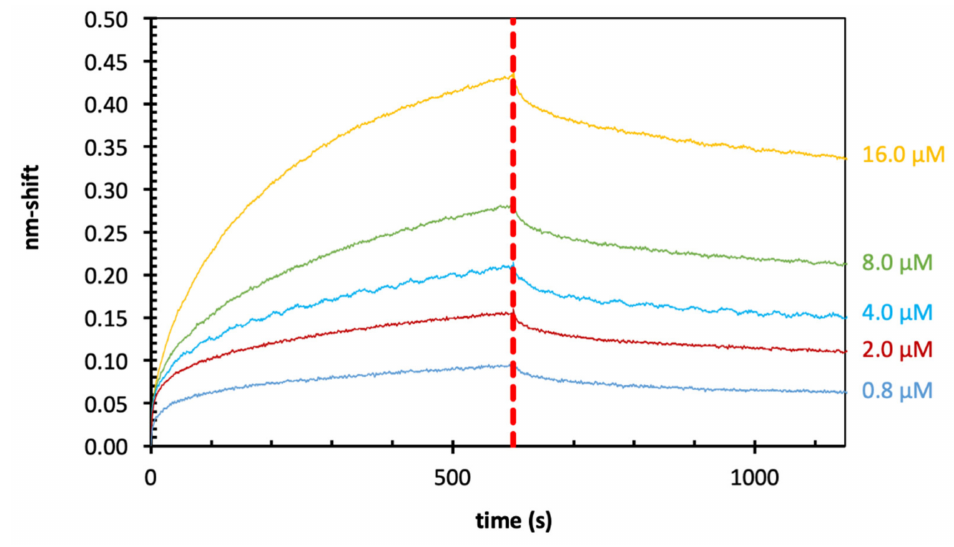
Figure 5. Results of BLI-experiments of Echinacea galactan to Gal-3 (super-streptavidin sensors).